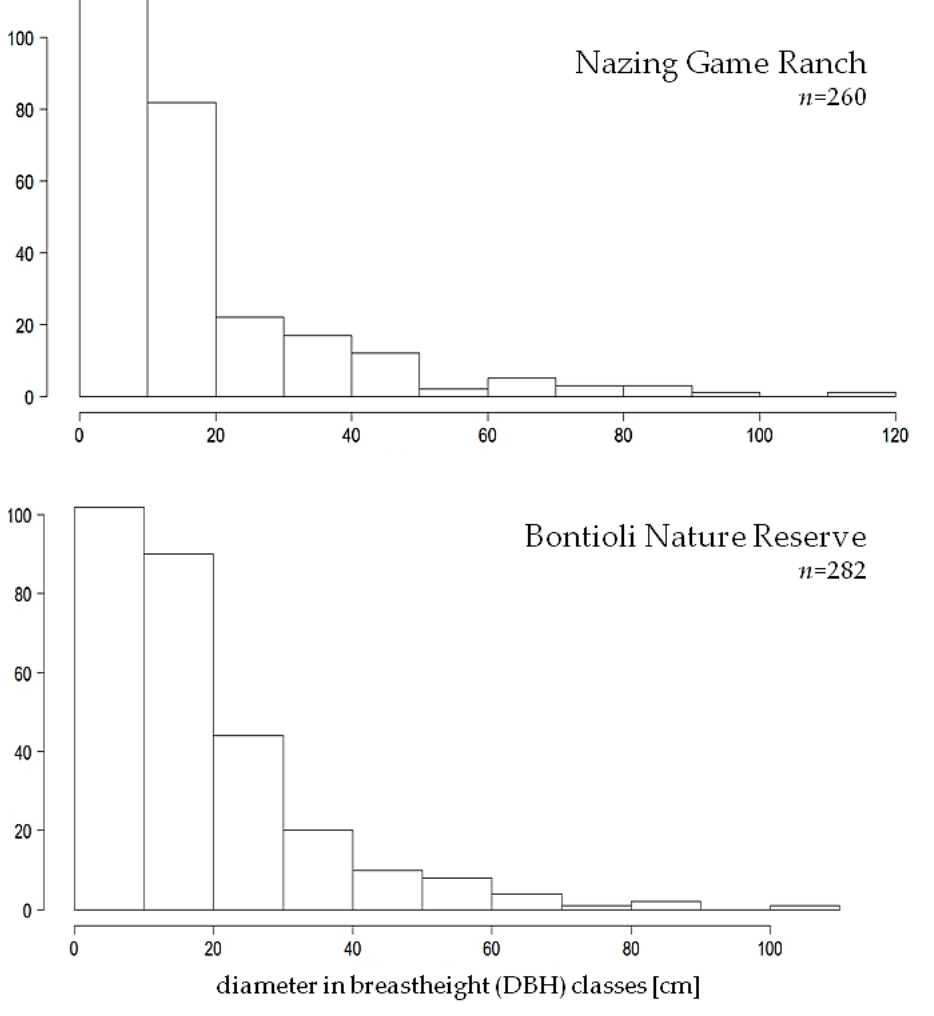
Figure 3. Distribution of individual trees in according DBH classes for both research sites, Nazinga Figure 3. Game Ranch (upper part) and Bontioli Nature Reserve (lower part). Nazinga Game Ranch (upper part) and Bontioli Nature Reserve (lower